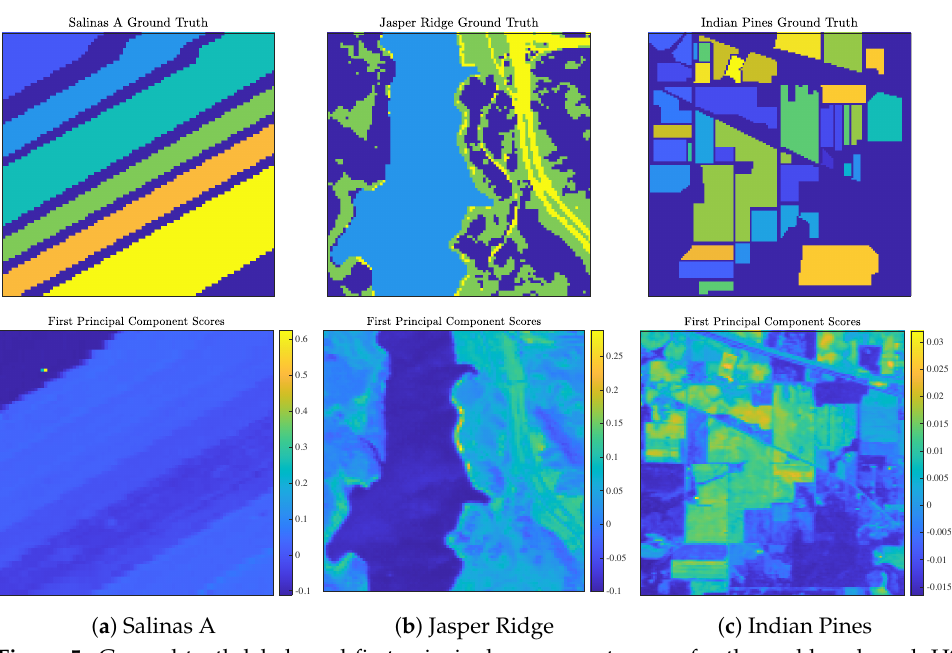
Figure 5. Ground truth labels and first principal component scores for the real benchmark HSIs analyzed in this article: Salinas A ( a ), Jasper Ridge ( b ), and Indian Pines ( c ). Table 1. Summary of benchmark HSI datasets analyzed in Section